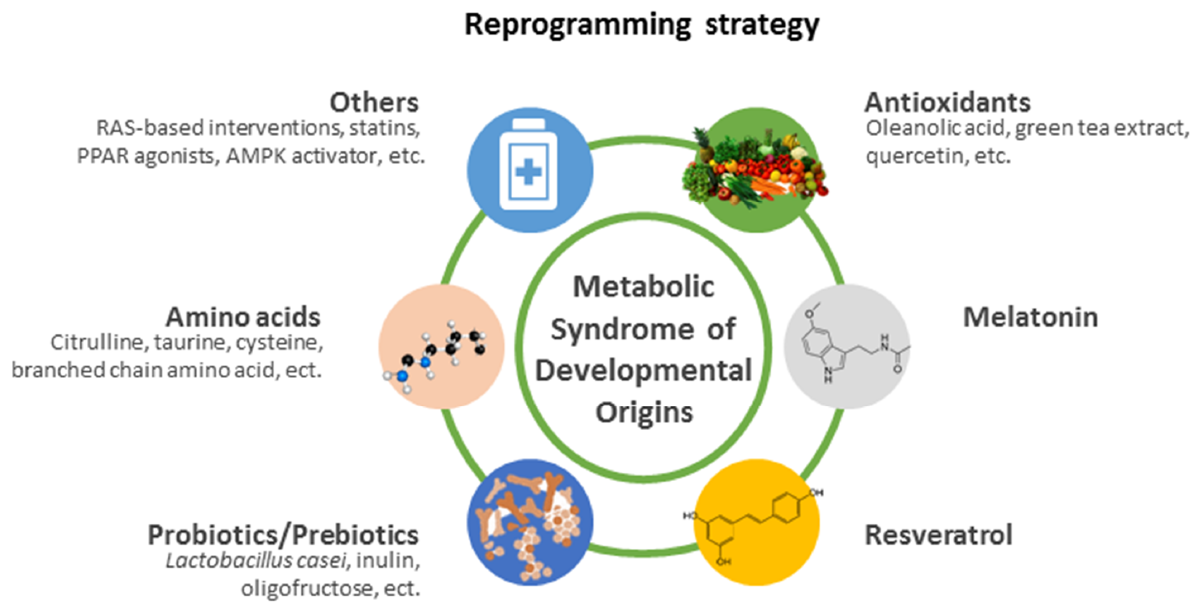
Figure 2 . A summary of the currently available reprogramming interventions to prevent metabolic syndrome of developmental origins. RAS = renin-angiotensin system. PPAR = peroxisome proliferator-activated receptor. AMPK = cyclic adenosine monophosphate-activated protein kinase.